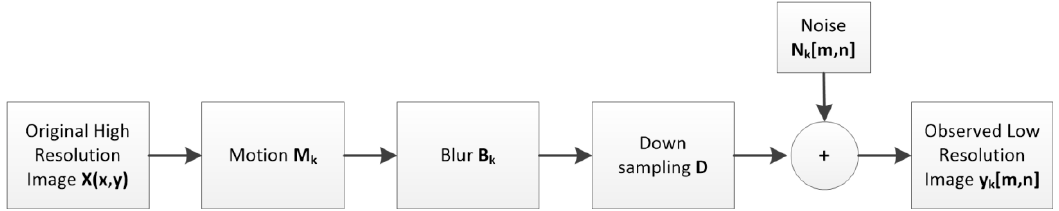
Figure 2. Multi-frame super-resolution observation model, where X ( x , y ) is the original image and this image is a high-resolution image. M k represents the translation and rotation caused by the inherent Brownian motion of the cell; B k represents the blurring of optics, motion, and sensors; D represents the down sampling, where the pixel units of the sensor are arranged tightly, and the down-sampling matrix is determined by the pixel size; and noise N k is mainly introduced by the sensor thermal noise.